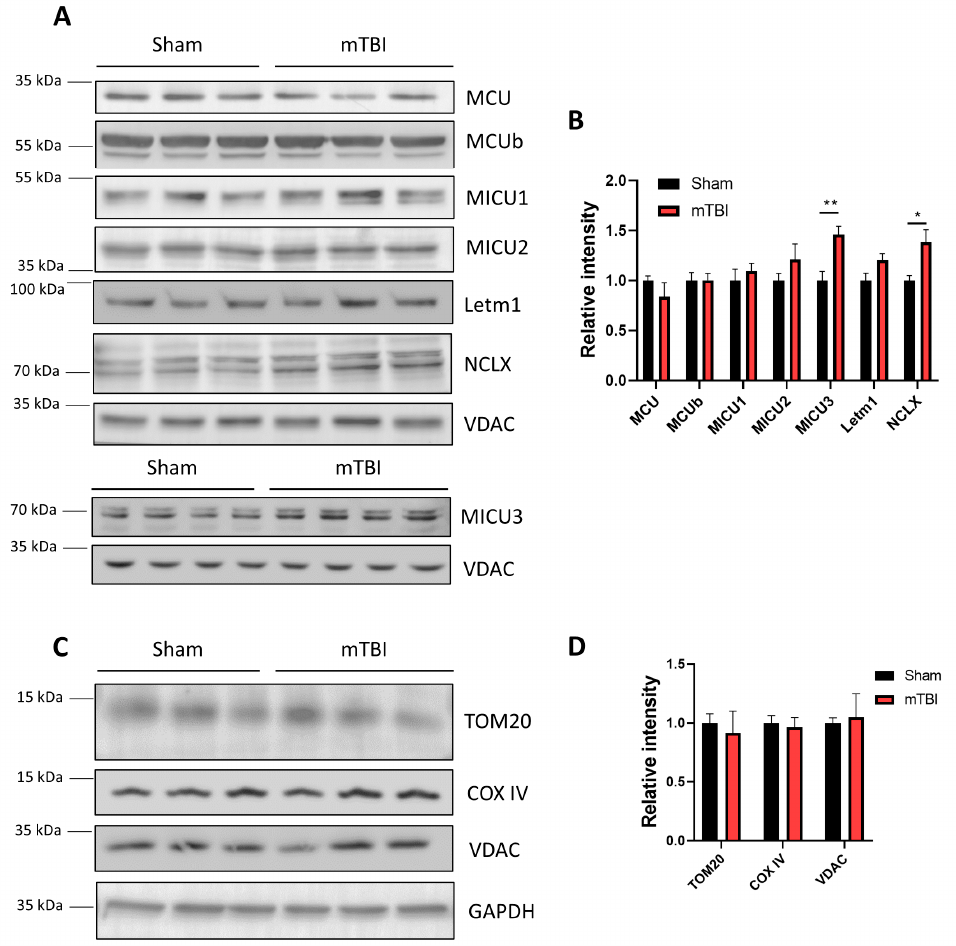
Figure 4. NCLX levels increased in mTBI mitochondria. ( A ) Immunoblot of mitochondrial fractions. It shows different MCU complex proteins: MCU, MCUb, MICU1, MICU2, and MICU3. It also shows sodium/calcium exchanger NCLX and proton/calcium exchanger Letm1. VDAC was used as the loading control. ( B ) Quantification of A. n = 3. For MICU3, n = 7. ( C ) Immunoblot of total hippocampal lysates. It shows two mitochondrial mass markers: TOM20, COX IV, and VDAC. GAPDH was used as the loading control. ( D ) Quantification of C. n = 3. For COX IV n = 6. Student’s t -test for every protein measured. * p < 0.05; ** p <